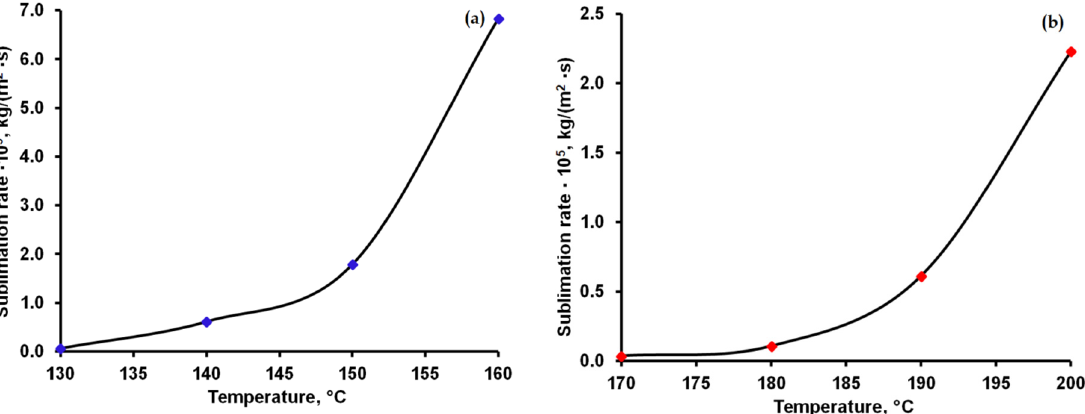
Figure 5. The variation of the sublimation rate depending on the temperature for caffeine ( a ) and theophylline ( b ).